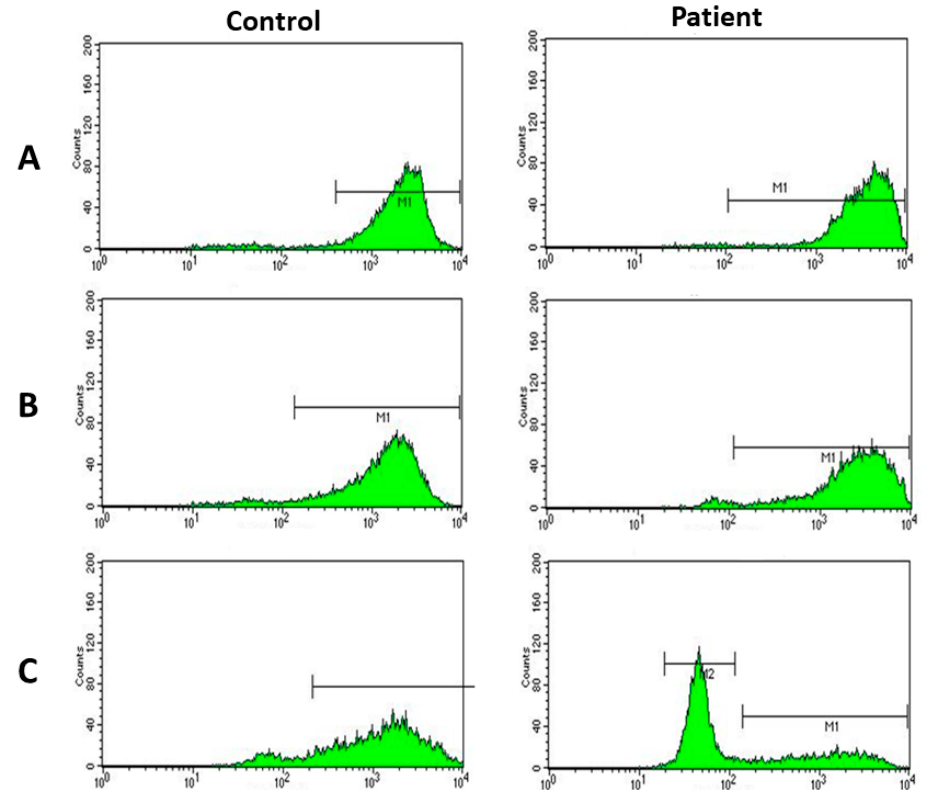
Figure 2. Dihidrorodamine test (DHR) in the control and the patient with Dermatophytosis. ( A ) DHR without stimulus; ( B ) DHR stimulated with S. aureus ; ( C ) DHR stimulated with Candida . Table 1. Immunological evaluation of the patient with T. rubrum infection.